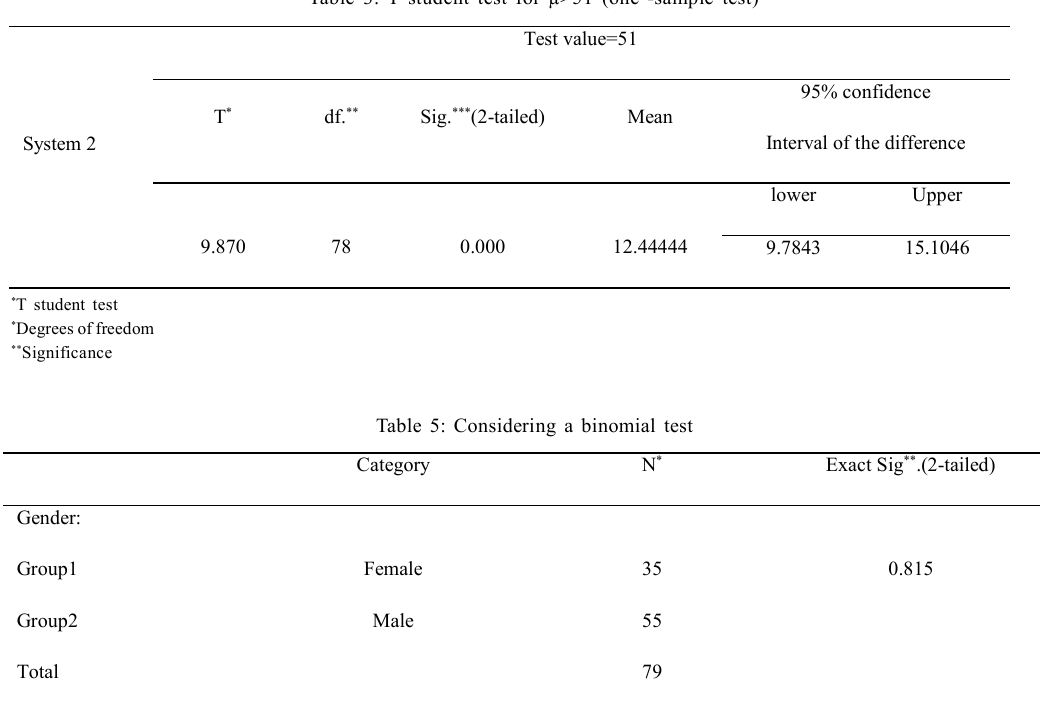
Table 3: T student test for µ>51 (one -sample test)